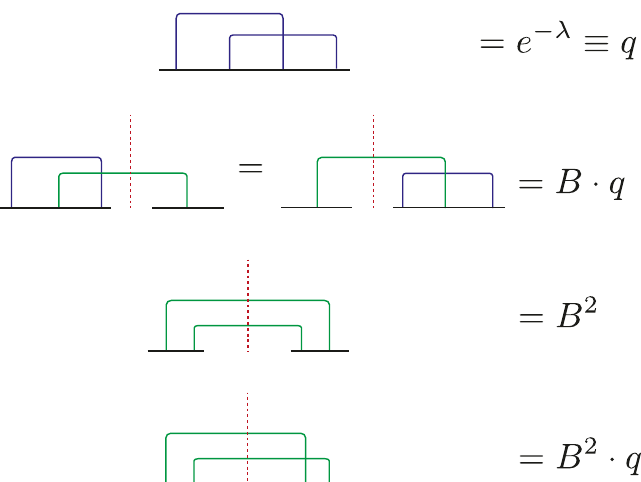
Figure 5 : Factors of chord configurations in the two space